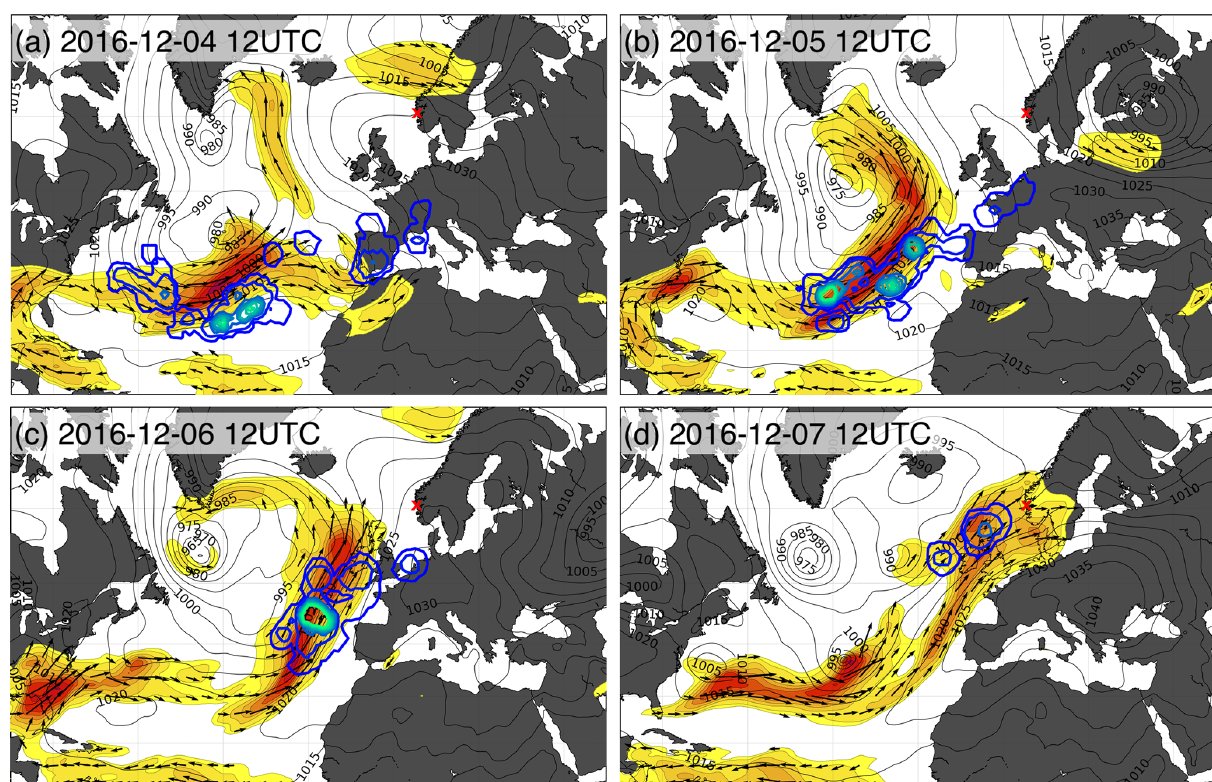
Figure 7. Synoptic situation at 12:00UTC on the 3d prior to the AR event day (a–c) and on 7 December 2016 (d) . Shown are integrated water vapour transport (IVT > 250kg ( ms ) − 1 , shading), mean sea level pressure (black contours, 5hPa interval), and concurrent moisture uptake (mm ( 6h ) − 1 , blue-green contours) that precipitates at the arrival location at 00:00UTC between 7 and 8 December 2016. The red cross indicates the measurement site Bergen,